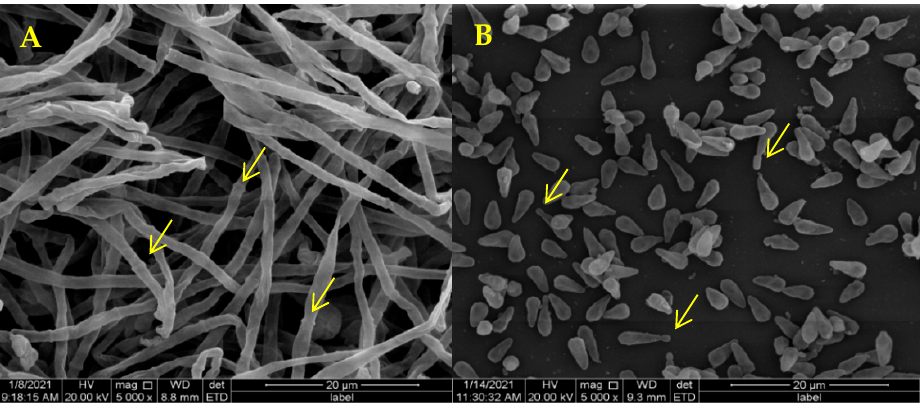
Figure 2. Mycelia ( A )and Spore ( B ) Morphology of D. coniospora YMF1.01759 using SEM.